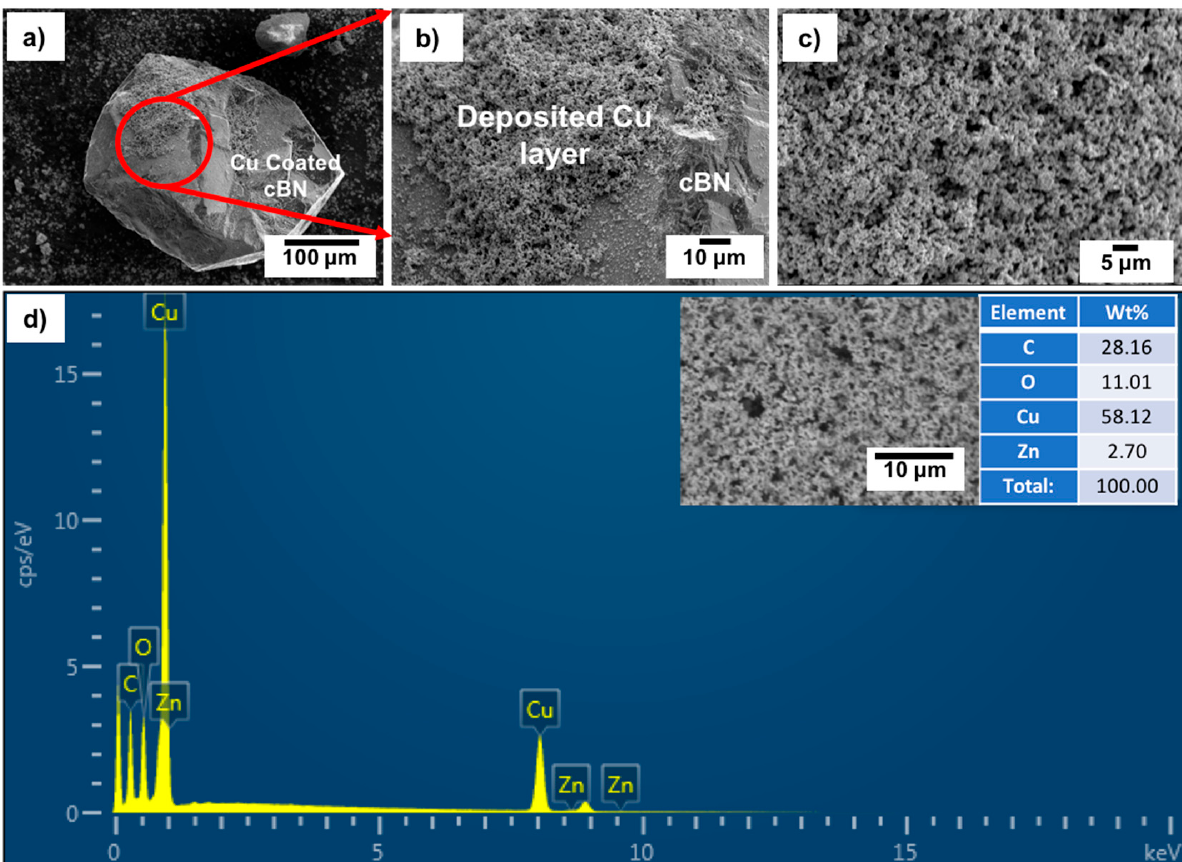
Figure 7. ( a – c ) FESEM images with different magnification and ( d ) EDAX compositional spot analysis of the un-metallized cBN/Cu composite particles (C peak is the background).